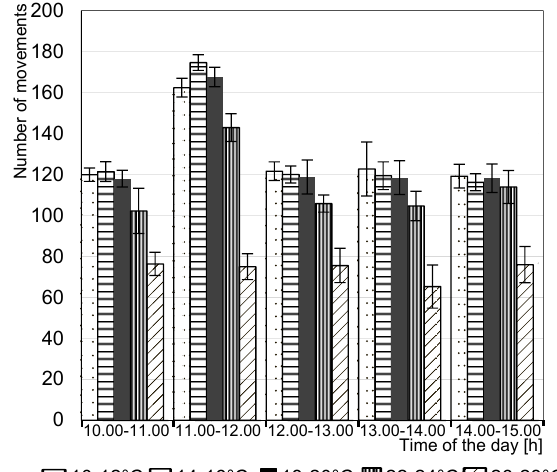
Fig. 3. Movements of round goby, Neogobius melanostomus (mean ± standard deviation) during one hour with normal atmospheric pressure (10:00–11:00 h, 13:00– 15:00 h) and with the atmospheric pressure increased by 1333 Pa (11:00–13:00